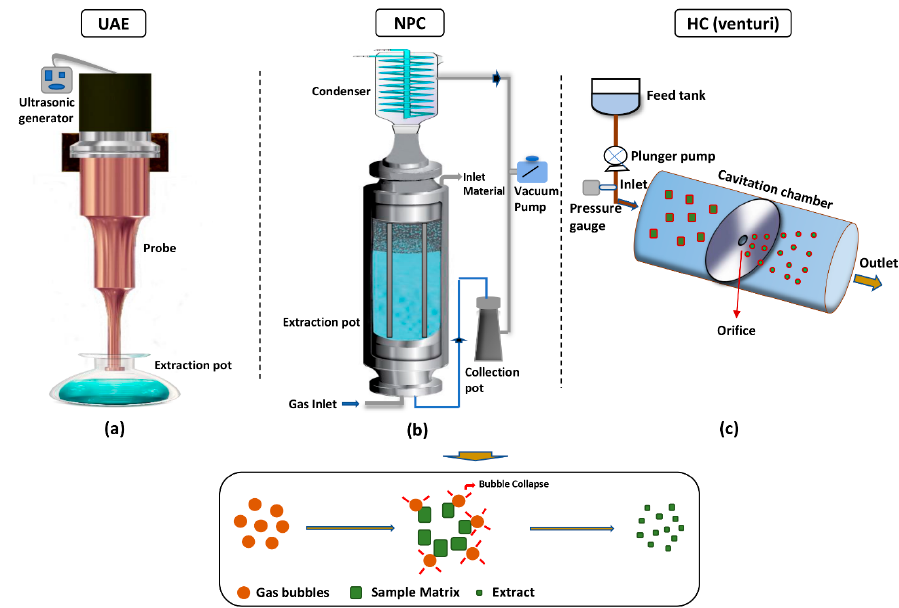
Figure 1. Types of cavitation reactor ( a ) UAE (ultrasound-assisted extraction); ( b ) NPC (negative pressure cavitation); ( c ) HC (hydrodynamic cavitation, venturi) and overall mechanism .